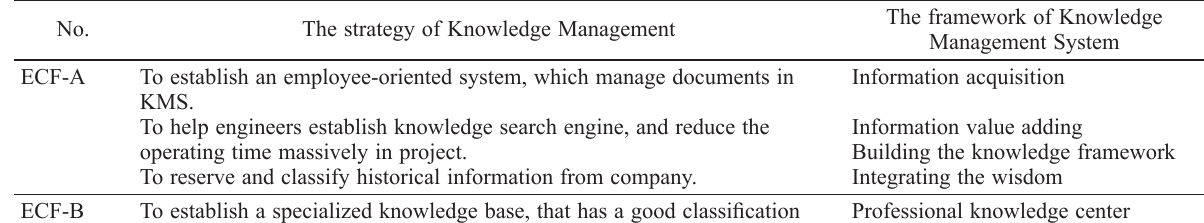
Table 2. The summary for KM and KMS of engineering consulting firms in case study